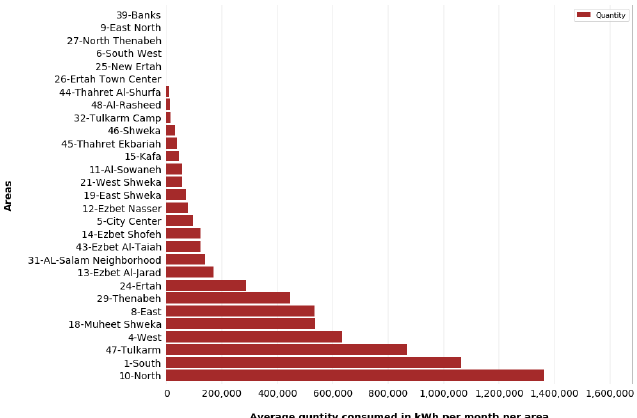
Figure 6. Average consumption in kWh per month per